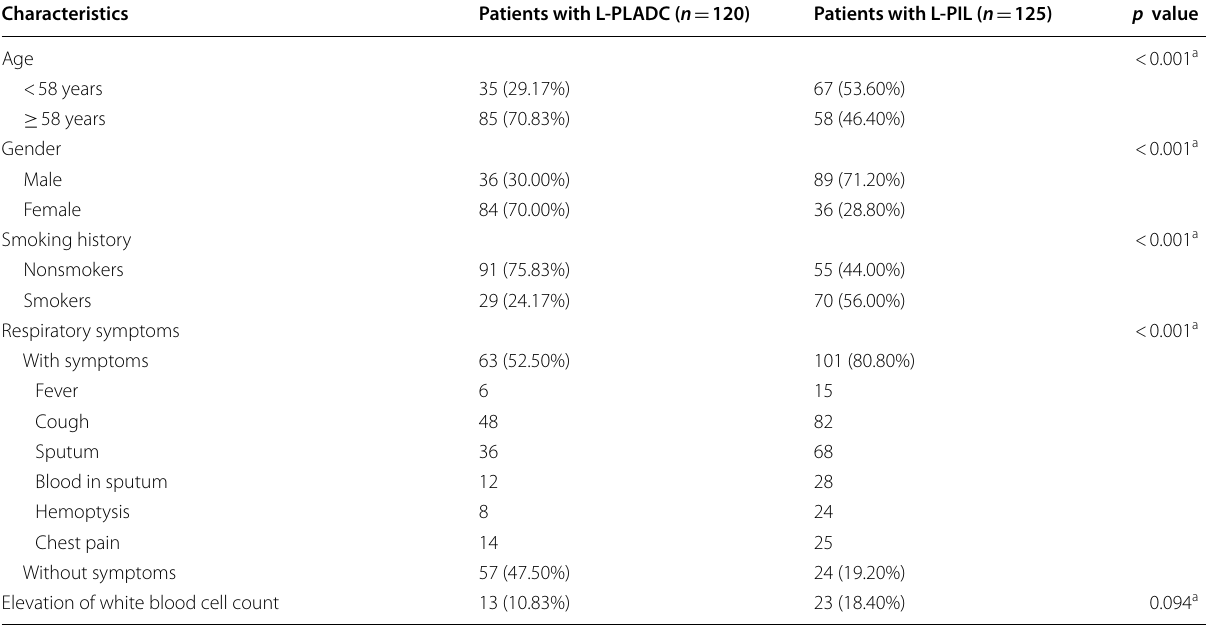
Table 1 Comparison of clinical characteristics between localized pneumonic‑type lung adenocarcinoma and pulmonary inflammatory